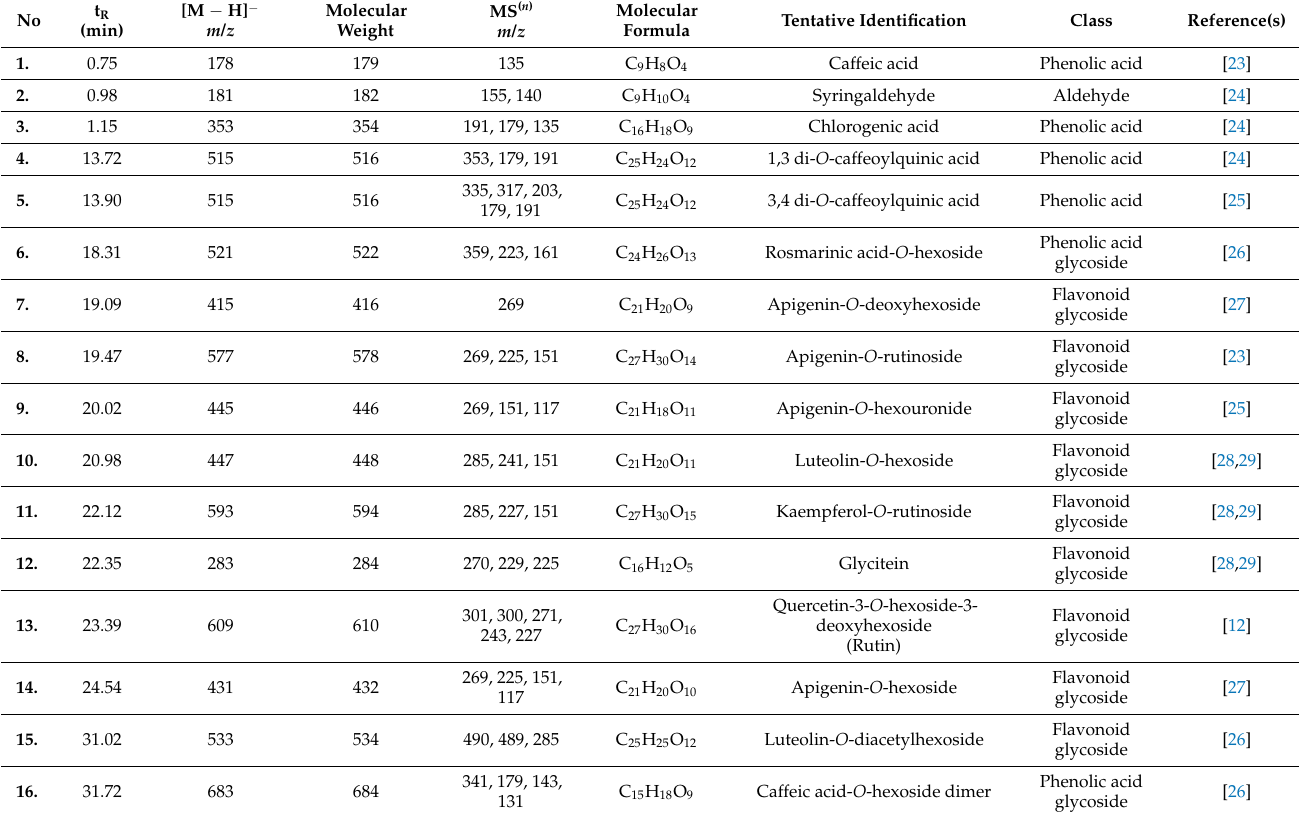
Table 1. Metabolite profiling of artichoke bracts methanolic extract (ART) as analyzed by UPLC-ESI-